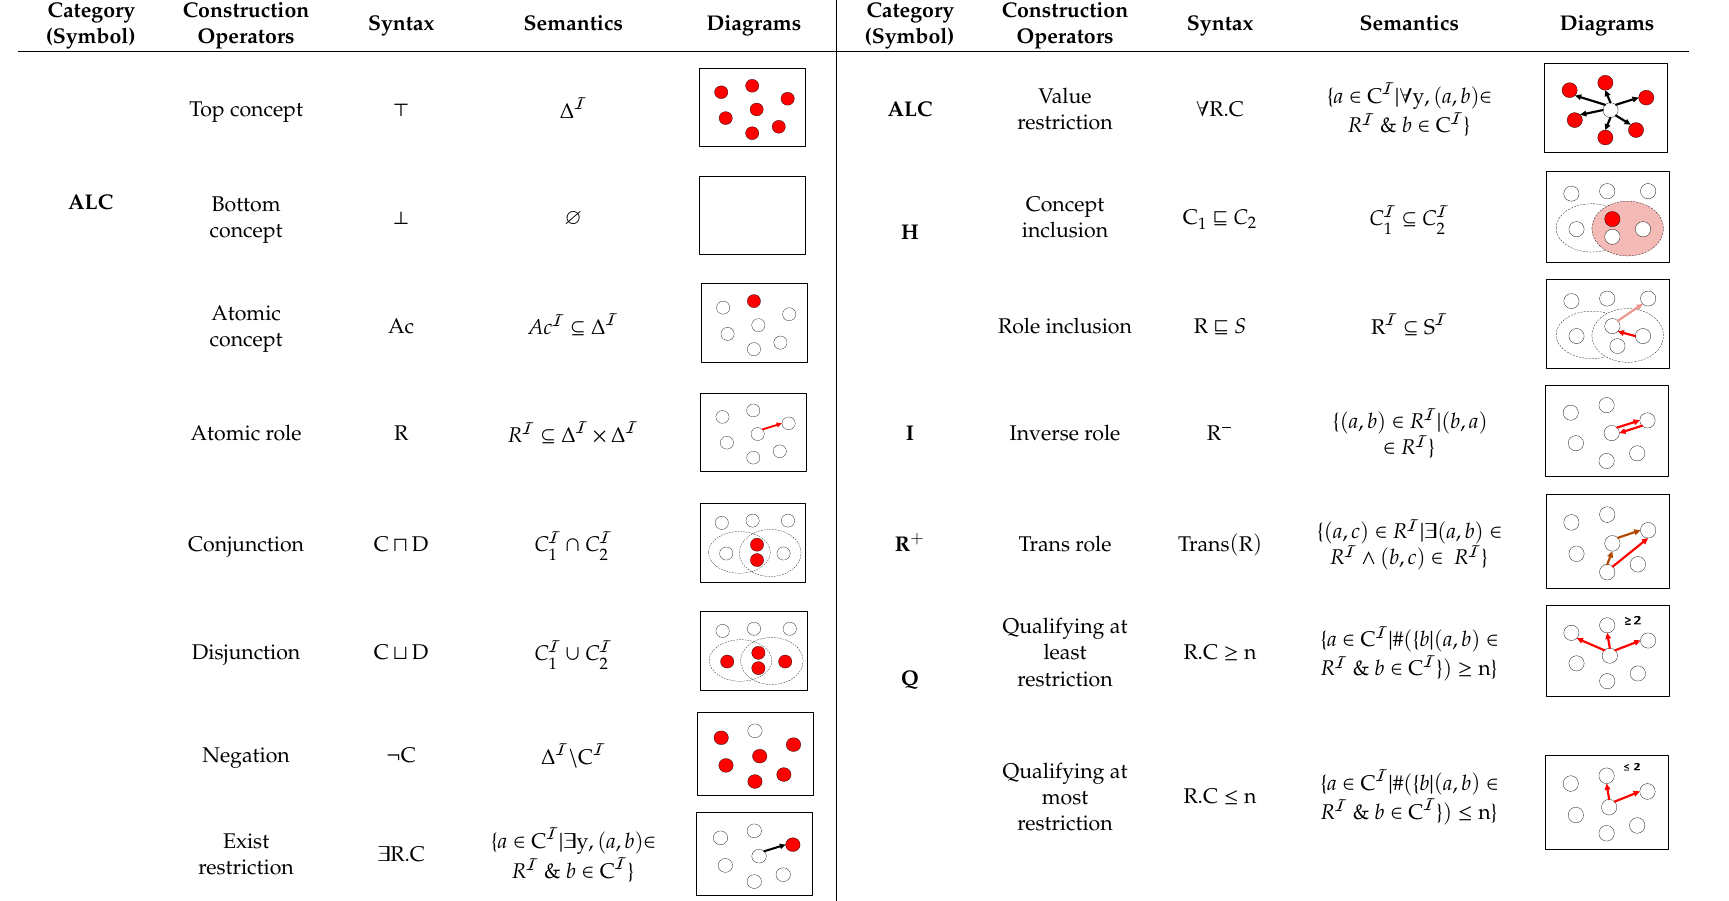
Table 1. Syntax and semantics of the main construction operators of the description